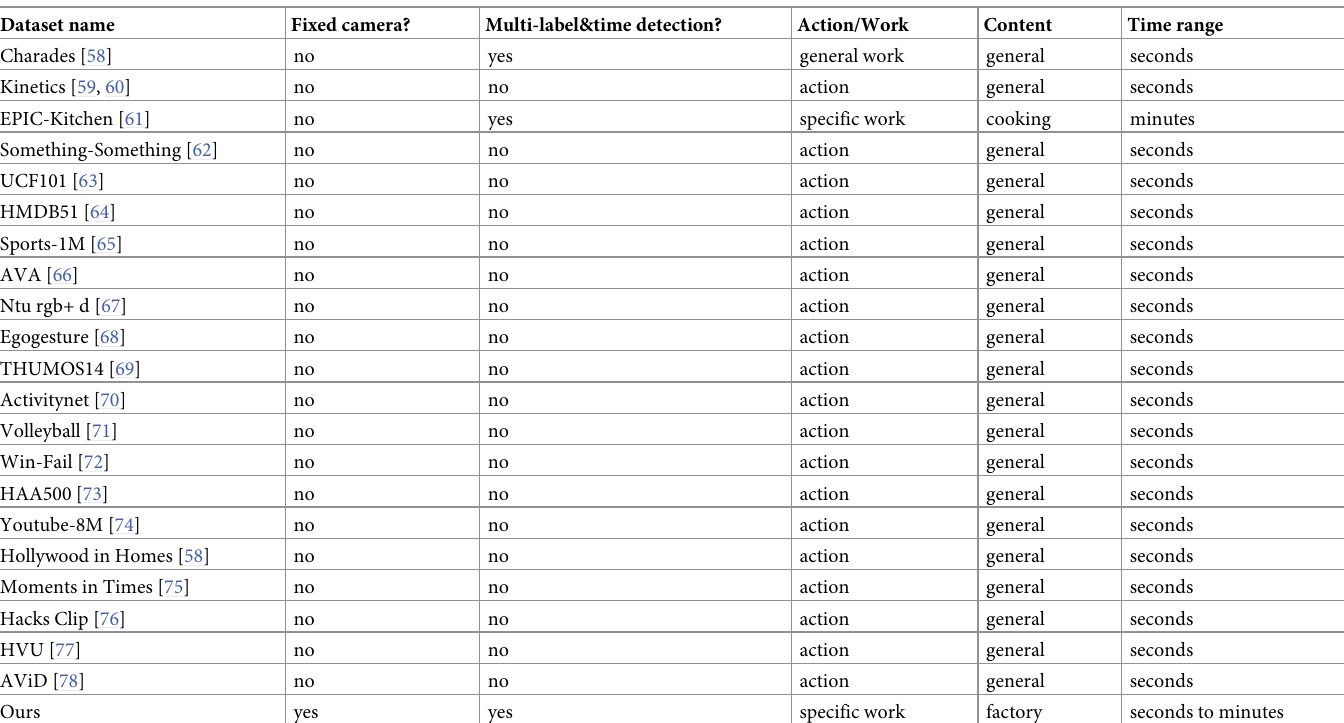
Table 2. Comparison of video datasets. Dataset